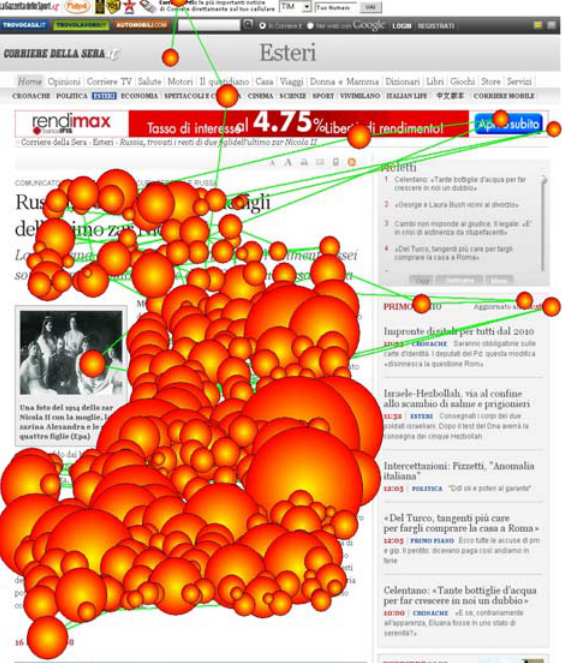
Figure 6 - Example of a scanpath made by one subject during story reading. Each circle is a fixation, green lines are saccades. The radius of each circle is proportional to fixation duration.